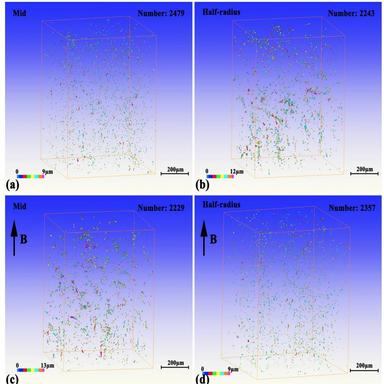
3D characterization of inclusions at different regions in MZ (with or without ASMF) in this study, (a) Mid region without ASMF, (b) Half-radius region without ASMF, (c) Mid region with ASMF, (d) Half-radius region with ASMF, respectively.